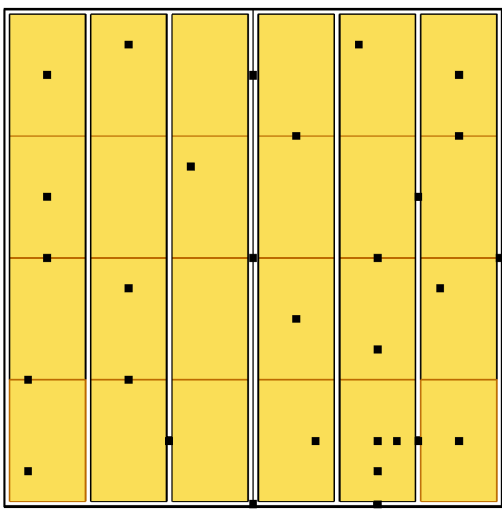
Figure 9. Locations of calculated surface temperatures with respect to the VIPs (highlighted in yellow), VIP ‐ VIP joints and foam gaps; the point calculations of surface temperatures were used to calculate the area ‐ weighted surface temperature difference.